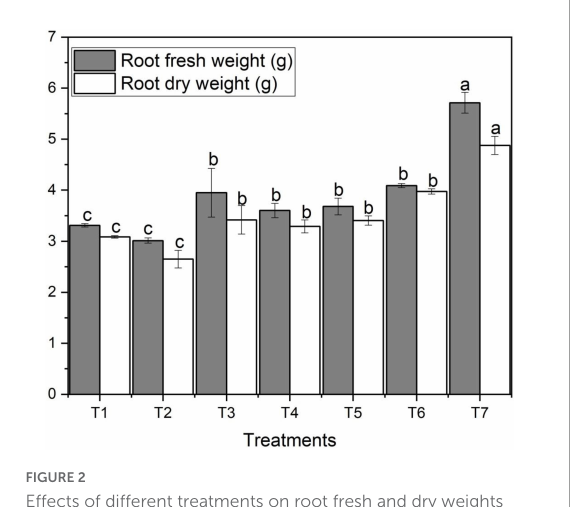
FIGURE2 Effects of different treatments on root fresh and dry weights under salinity stress. Different letters indicate a significant difference by Duncan’s multiple range tests at p < 0.05. Values are means ± SE ( n = 3). T 1 : without fertilizer application